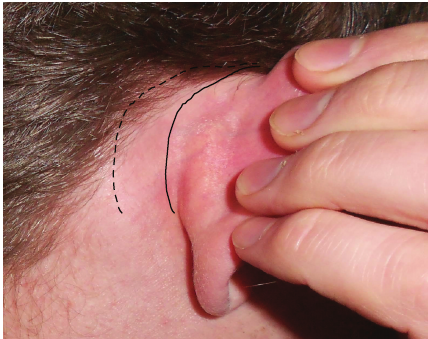
Figure 1: Photograph showing the locations of sulcal (solid line) and hairline (dashed line) postauricular incision for access to the